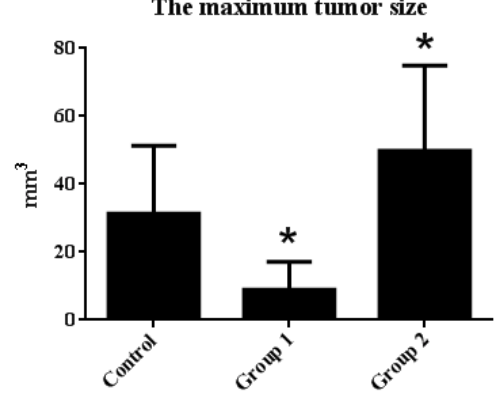
Figure 4. The maximum tumor size statistical results. Tumor diameter was measured by caliper, and the maximum tumor size in each group was calculated by the following equation: tumor size = 3/4 × length × width × height. The results are expressed as means ± S.D.; the amount of sample in each group was n = 8 (blank group), n = 6 (control group), n = 7 (Group 1), n = 7 (Group 2). p > 0.05 and * p < 0.05 when compared with the control group.